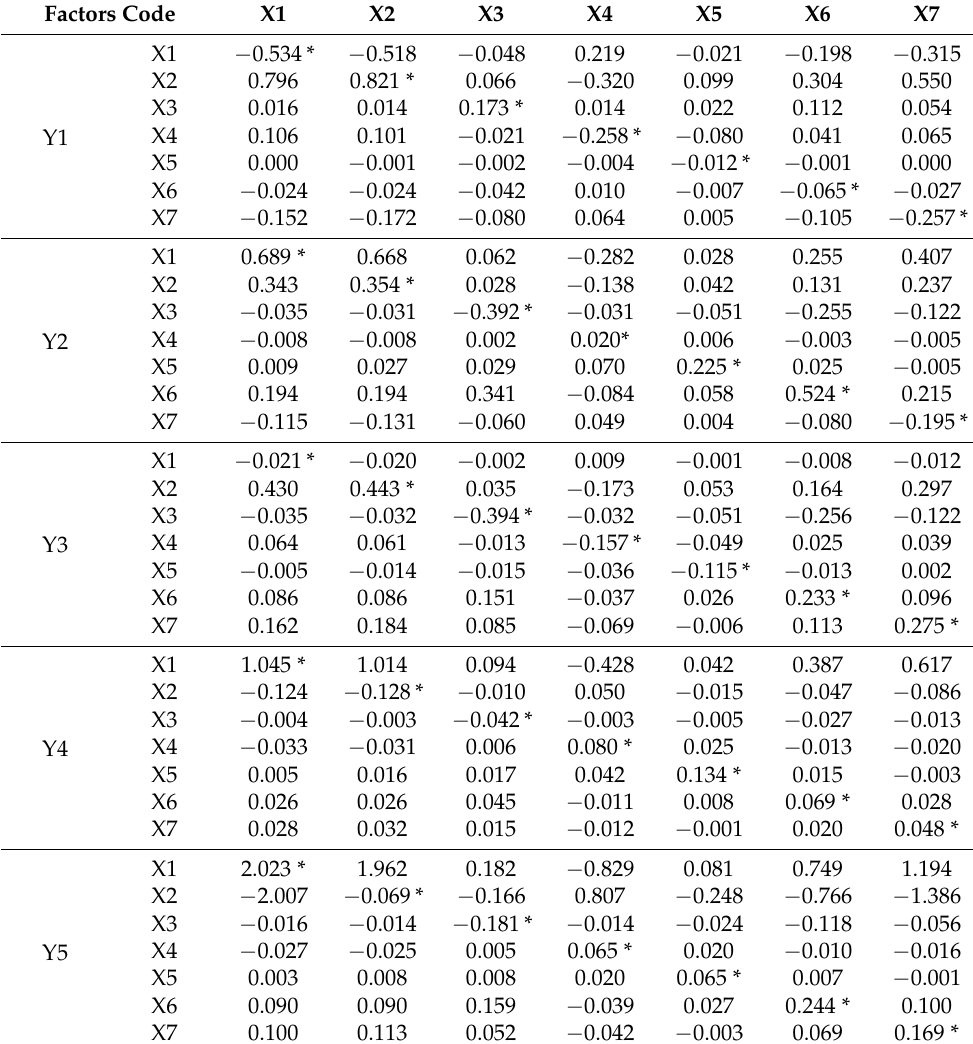
Table A1. Path coefficients between soil nutrients factors (X) and soil enzyme activity (Y) in PMM.